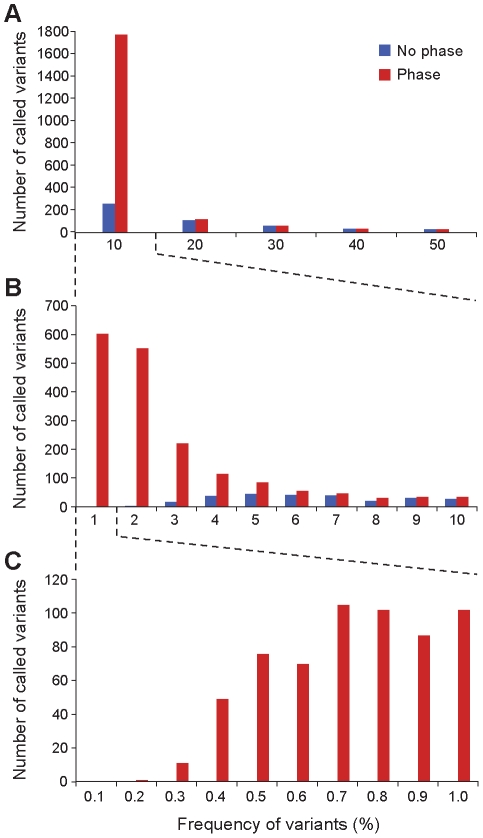
Low frequency variants overwhelmingly called with phase.Histogram shows low frequency variants overwhelmingly called with phase thresholds. Variants frequencies are estimated by the frequencies of variants among the reads at that position. Versions of V-Phaser with and without phase thresholds called variants on a clinical sample that are binned by their frequency at their locus. Most variants <5% were detected only be V-Phaser with phase thresholds, and the version without phase thresholds detected no variants <1%.